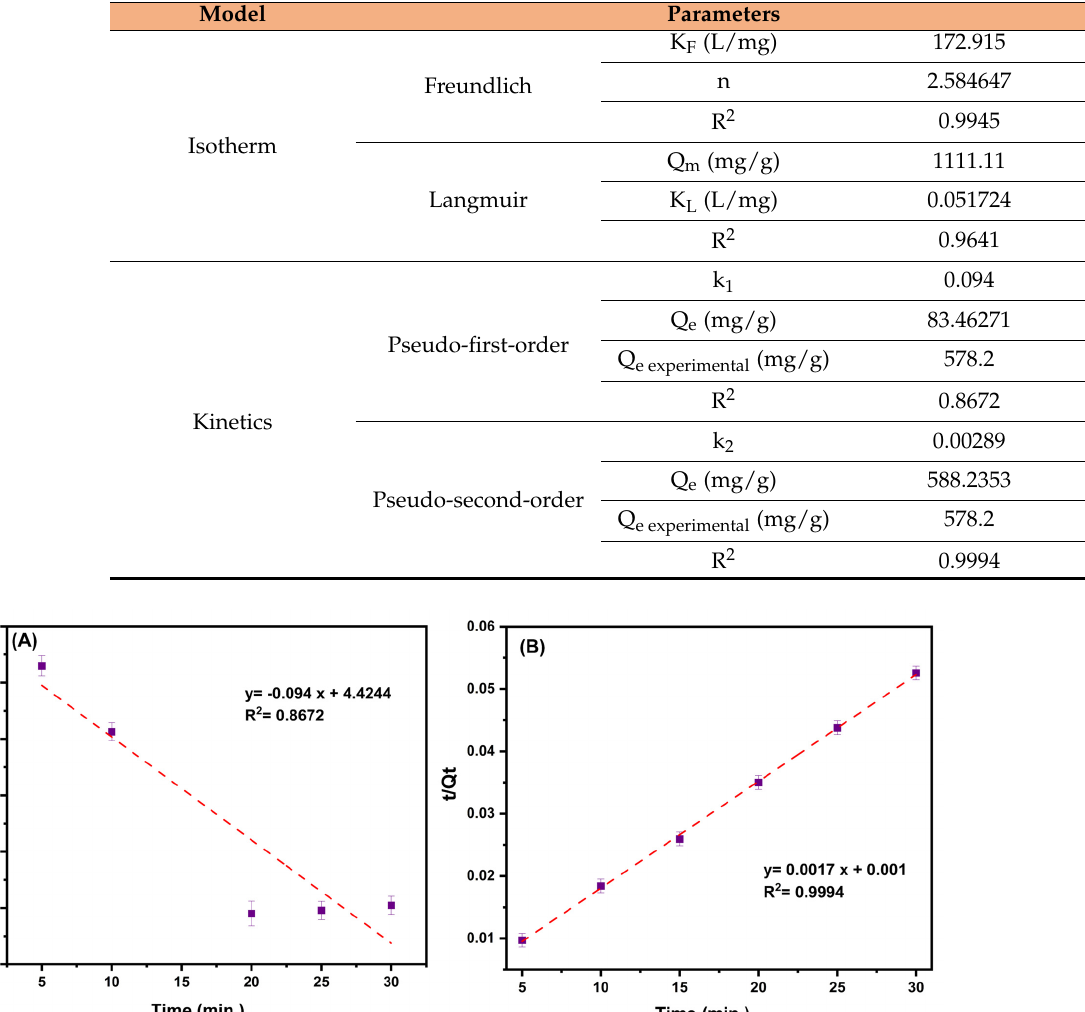
Table 4. Isotherm and kinetic constants, correlation coefficients, and statistical parameters, for adsorption of ciprofloxacin on the MMIP.